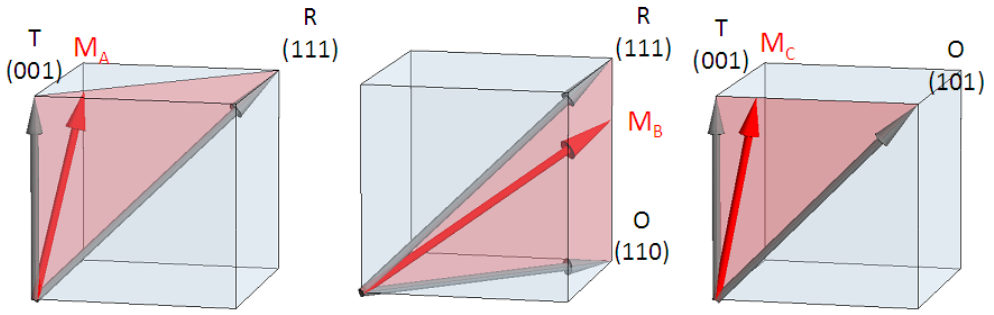
Figure 9. Direction of the spontaneous polarization in the three types of monoclinic phases with the usual nomenclature M A , M B ( Cm ) and M C ( Pm ) introduced in [58] (see also e.g.,